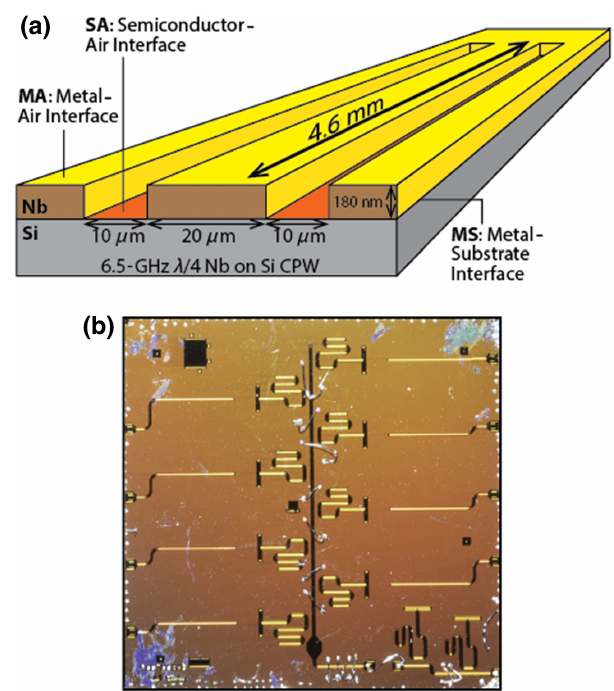
FIG. 1. (a) A sketch of the λ/ 4 CPW resonators used in this study. The frequencies range from 6 to 7 GHz and a 6.5-GHz approximately 50- (cid:4) resonator is 4.6 mm long, grounded at one end and open at the other. The center conductor is 20 μ m wide with 10- μ m insulating gaps. The Nb superconducting layer is approximately 180 nm thick and the substrate is high-resistivity Si(100). The material interfaces are indicated. (b) An optical image of a 10 mm × 10 mm Nb-on-Si resonator test chip after cryogenic loss measurements, showing the central vertical read- out line with four resonators on each side. The horizontal traces from the left and right edges would have been control lines on an eight-qubit chip. Two additional resonators are included at the lower right. The Nb ground plane has 2 μ m × 2 μ m square magnetic flux traps etched through the Nb on a 10- μ m